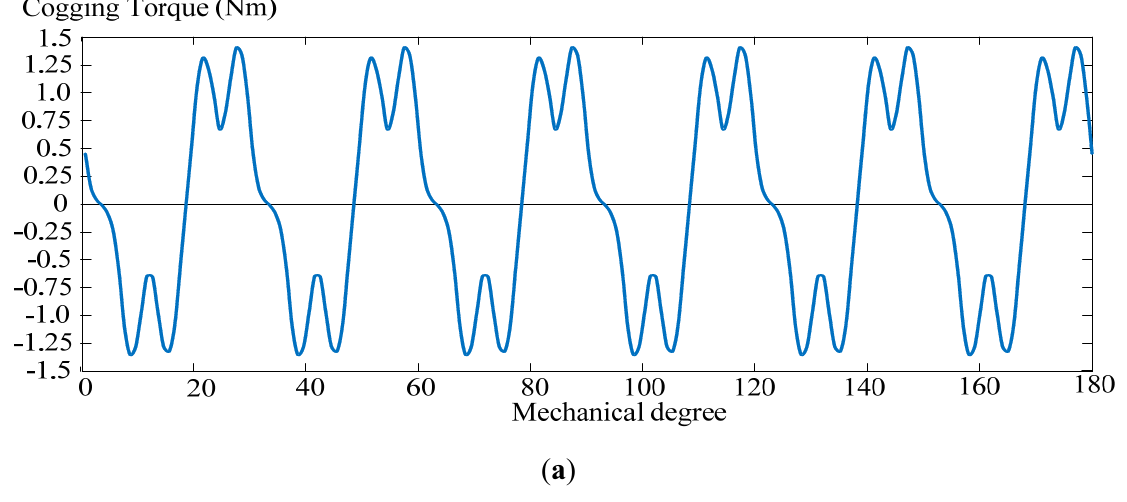
Figure 5. Cogging torque of HMPP for a 10-pole, 12-slot PMSM: ( a ) 0 degree; ( b ) 5 accumulated mechanical